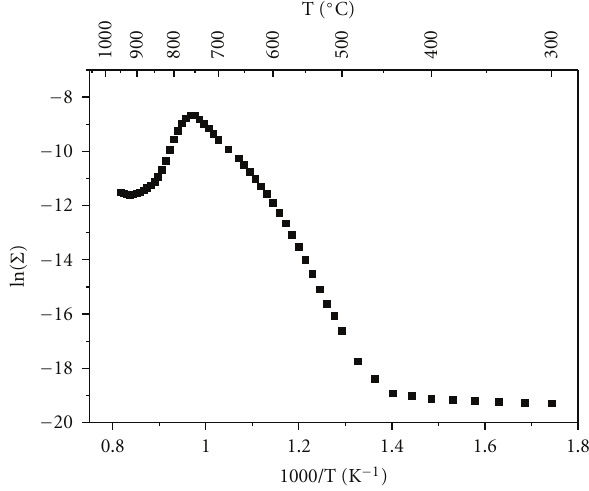
Figure 5: Evolution of ln( Σ ) versus 10 3 /T of initial La 2 O 3 sample during its carbonatation and decarbonatation, in the temperature range 300 to 950 ◦ C, under a constant CO 2 gas flow: (a) starting step of carbonatation between 450 and 750 ◦ C with two conduction regimes; (b) decarbonatation step above 750 ◦